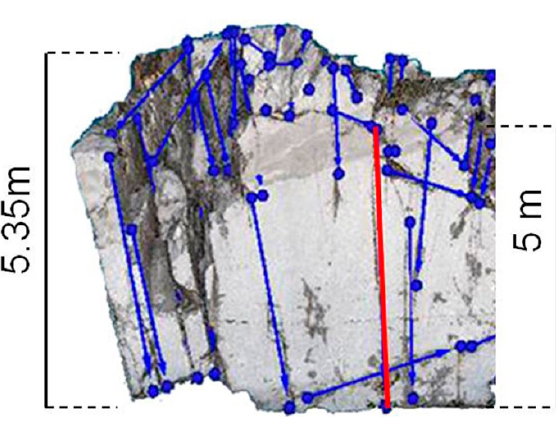
Figure 14. Example of persistence calculation.